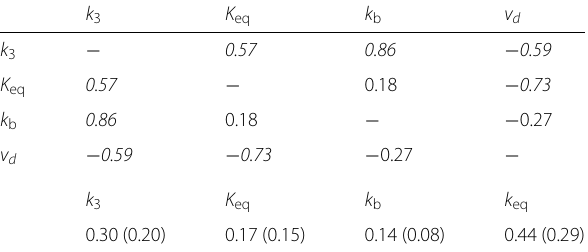
clinically, however, and it is often assumed that one can adopt static imaging in place of kinetic imaging when some appropriate uptake metric–SUV for FDG- PET or TBR for hypoxia-PET–is well-correlated with k 3 [27, 28]. Table 3 Top: Correlation matrix of Pearson correlation coefficients between the mean voxel-scale parameters across the twenty tumours studied using the 2-h data sets. Bottom: Population-averages of the corresponding voxel-scale rate coefficients; values are shown in units of h − 1 . Standard deviations of mean values across patients are indicated in parentheses. Also shown is the population average k eq value, which was calculated from fits to data from all voxels in each tumour, as described in the text k 3 K eq k b v d k 3 − 0.57 0.86 − 0.59 K eq 0.57 − 0.18 − 0.73 k b 0.86 0.18 − − 0.27 v d − 0.59 − 0.73 − 0.27 − k 3 K eq k b k eq 0.30 (0.20) 0.17 (0.15) 0.14 (0.08) 0.44